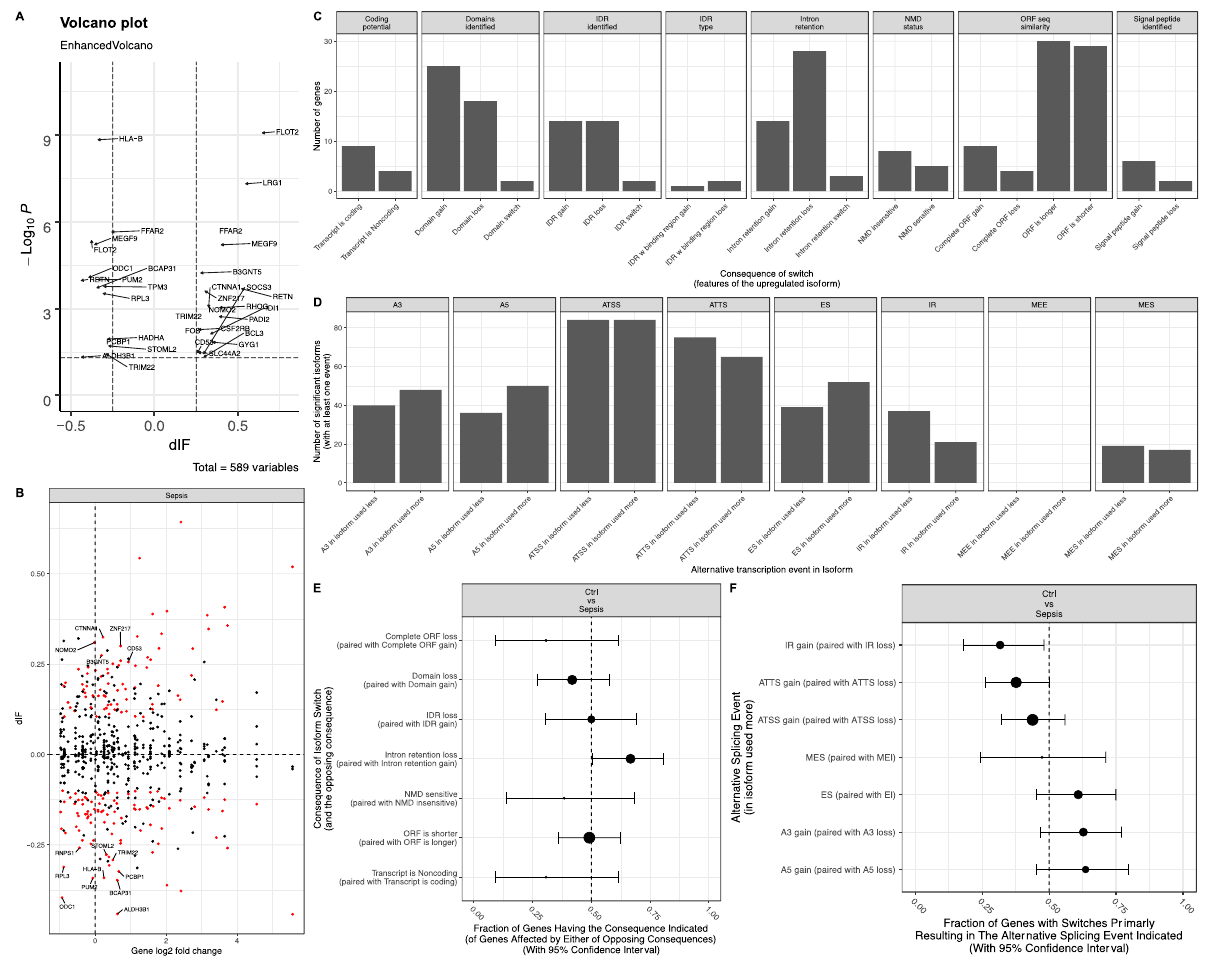
Figure 4. Isoform switching between patients with sepsis and controls as determined by pooling all data of sepsis types together. ( A ) Volcano plot shows differentially expressed isoforms, and the genes with significant p values and dIFs are labeled with gene names. The dashed lines indicate significance values for a dIF = 0.1 and FDR = 0.05. ( B ) Comparison between gene expression and dIF. Red indicates genes with significant isoform switching. Genes without significant fold changes but with significant dIF are labeled with gene names. ( C ) Consequences of isoform switching between the patients with sepsis and the controls. ( D ) Alternative splicing events in isoforms. ( E ) Genome-wide enrichment of specific consequences for each set of opposing consequences (e.g., domain gain vs loss) by analyzing the fraction of events associated with each consequence. IR loss is significantly more likely to occur than IR gain. ( F ) Enrichment of specific splice events for each set of opposing events (e.g., IR gain vs loss) as determined by analyzing the fraction of events associated each type of consequence. dIF difference in the isoform fraction, FDR false discovery rate, IR intron retention, IDR intrinsically disordered regions, NMD nonsense-mediated decay, ORF open reading frame, IR intron retention. A5 alternative 5 ′ donor site (changes in the 5 ′ end of the upstream exon), A3 alternative 3 ′ acceptor site (changes in the 3 ′ end of the downstream exon), ATSS alternative transcription start site, ATTS alternative transcription termination site, ES exon skipping, MES multiple exon skipping, skipping > 1 consecutive exon, MEE mutually exclusive